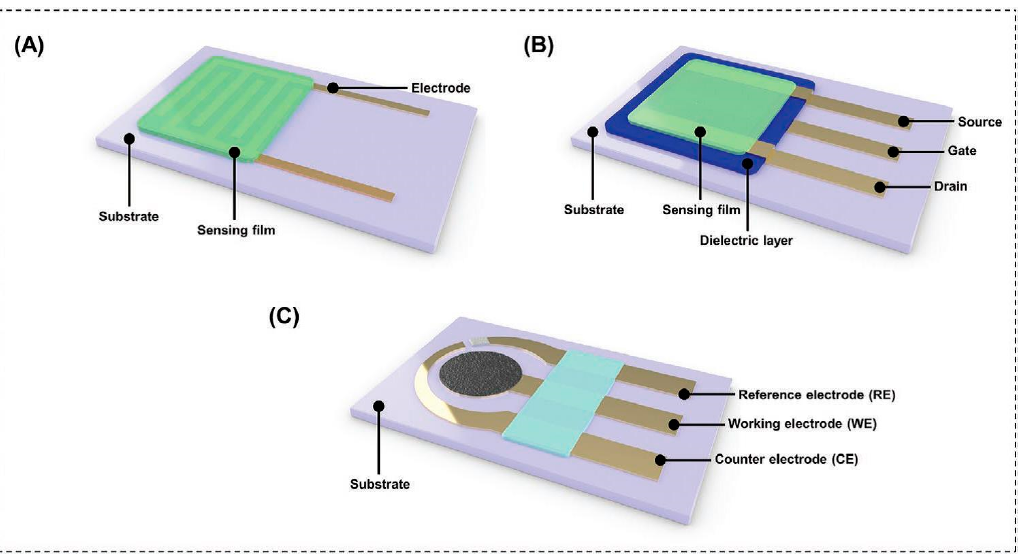
Figure 4. Schematic representation of ( A ) a chemiresistor under a constant bias and with an overlying metallic or semiconducting sensing layer which acts as the sensitive gas-sensing layer; ( B ) a field-effect transistor where the conductivity of the channel is sensitive to gas-analytes exposure; ( C ) an electrochemical sensor (potentiometric, amperometric, or conductometric) composed of a working (sensing) electrode on which the analyte reacts (redox reaction), a counter electrode (with respect to which electrical signal is measured) and a reference electrode of “reference” potential. Reprinted with permission from Ref. [13] Copyright © 2021 Wiley-VCH GmbH.